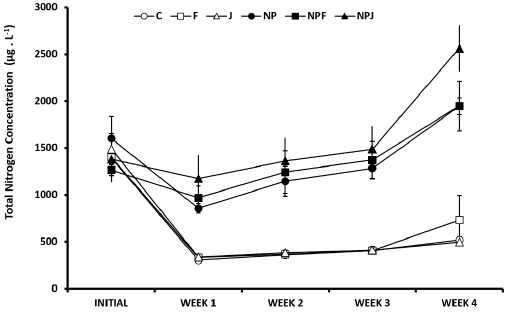
Figure 2. Medium values (+ - SE) for Total Nitrogen concentration analysis in six combinations of nutrients (NP), fingerlings (F) and juvenile (J) Nile tilapia treat- ments in a four-week tropical shallow lake experiment.